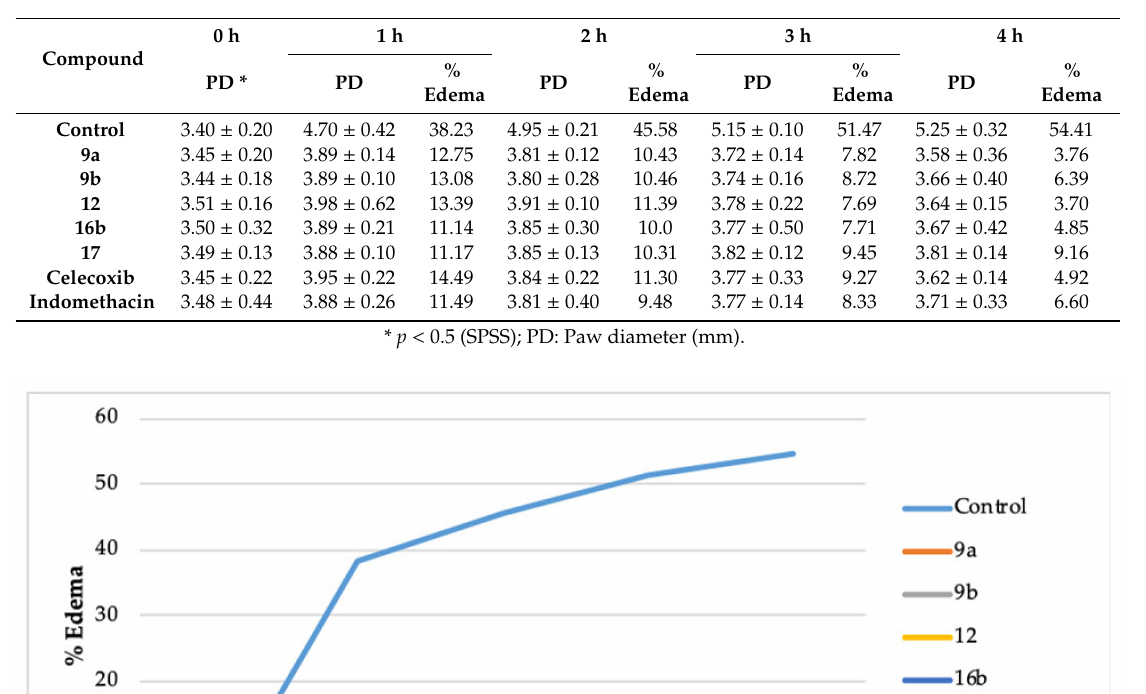
Table 2. In vivo anti-inflammatory activity of 9a , 9b , 12 , 16b , and 17 .